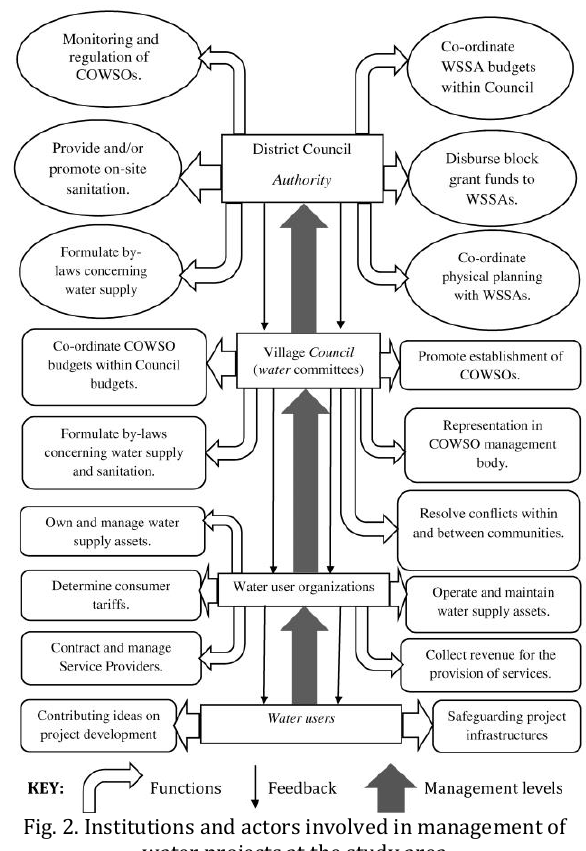
Fig. 2. Institutions and actors involved in management of water projects at the study